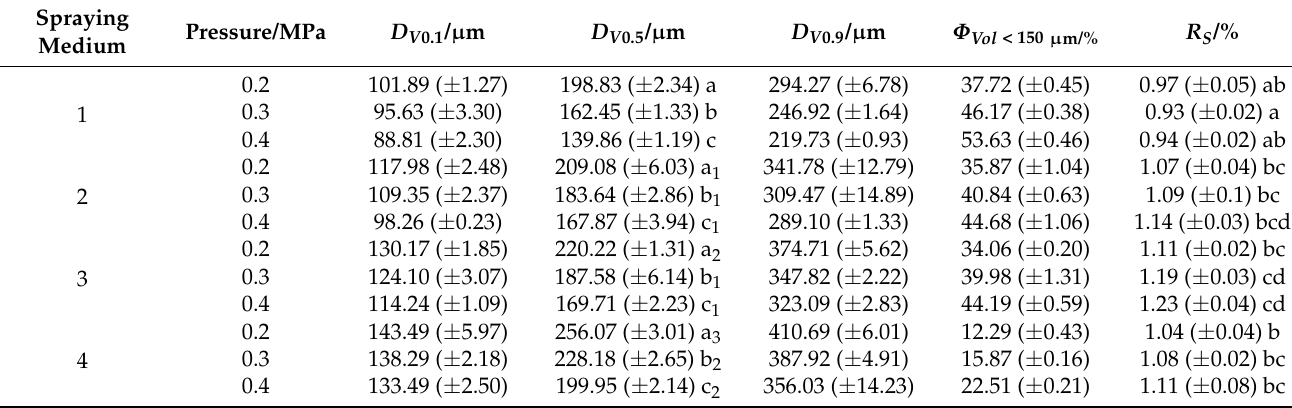
Note: The different letter after D V 0.5 indicates a significant difference between different spray media under the same pressure (the letters a, b, c represent three pressures and the number subscripts 1, 2, 3, 4 represent 4 spraying media), and the different letter after Rs indicates a significant difference between the same column of data ( p <